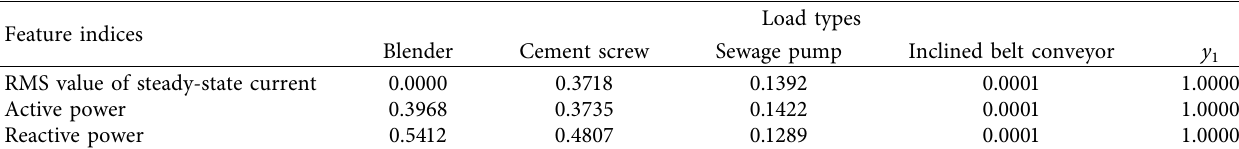
Table 7: Normalized load steady-state feature matrix